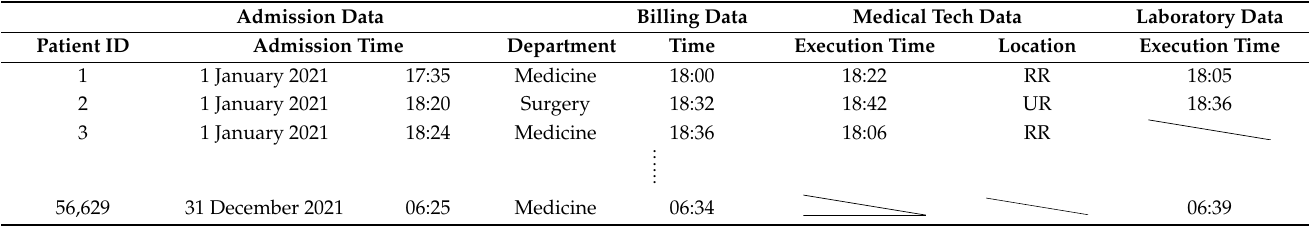
Table 1. List of extracted data.